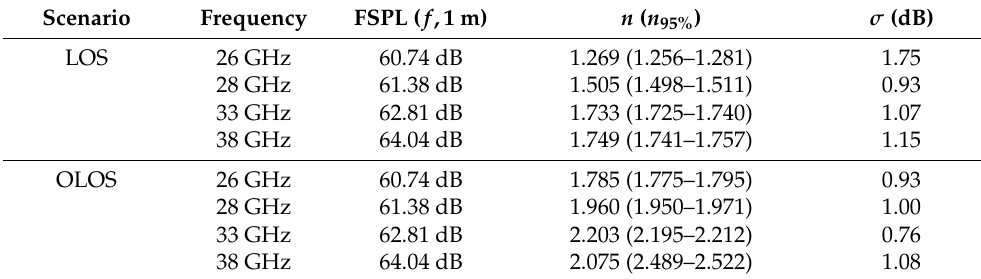
Table 3. Parameters of the CI model.